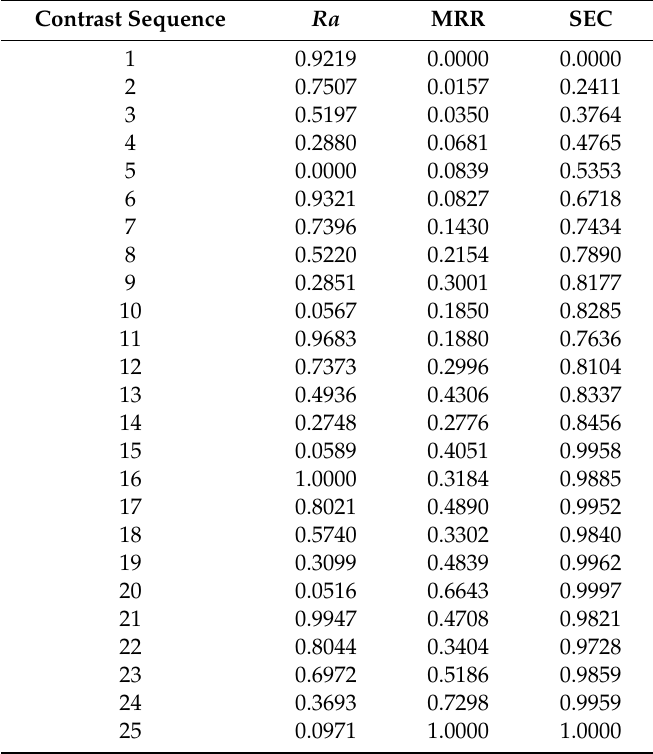
Table 5. The results of data